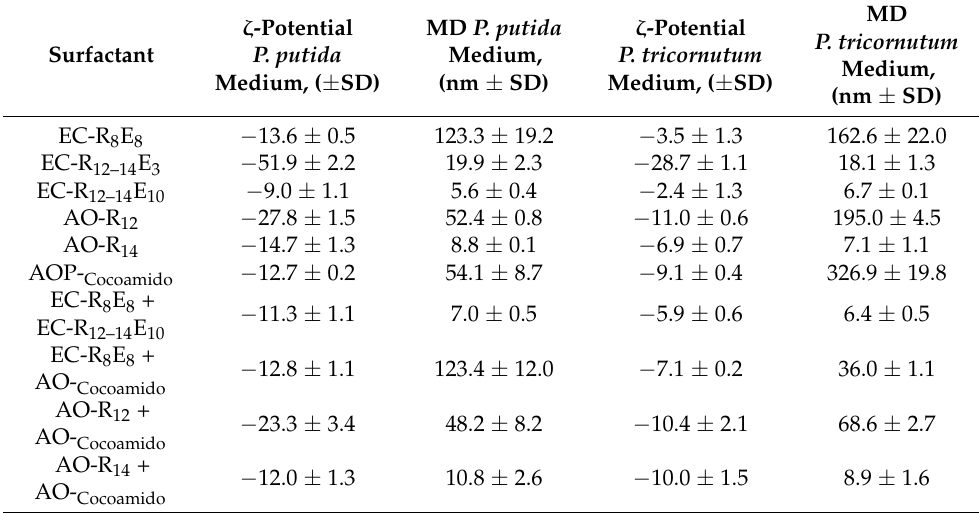
Table 3. ζ -potential and MD of surfactants and surfactants mixtures (1:1 w / w ) in culture media of P. putida and P. tricornutum